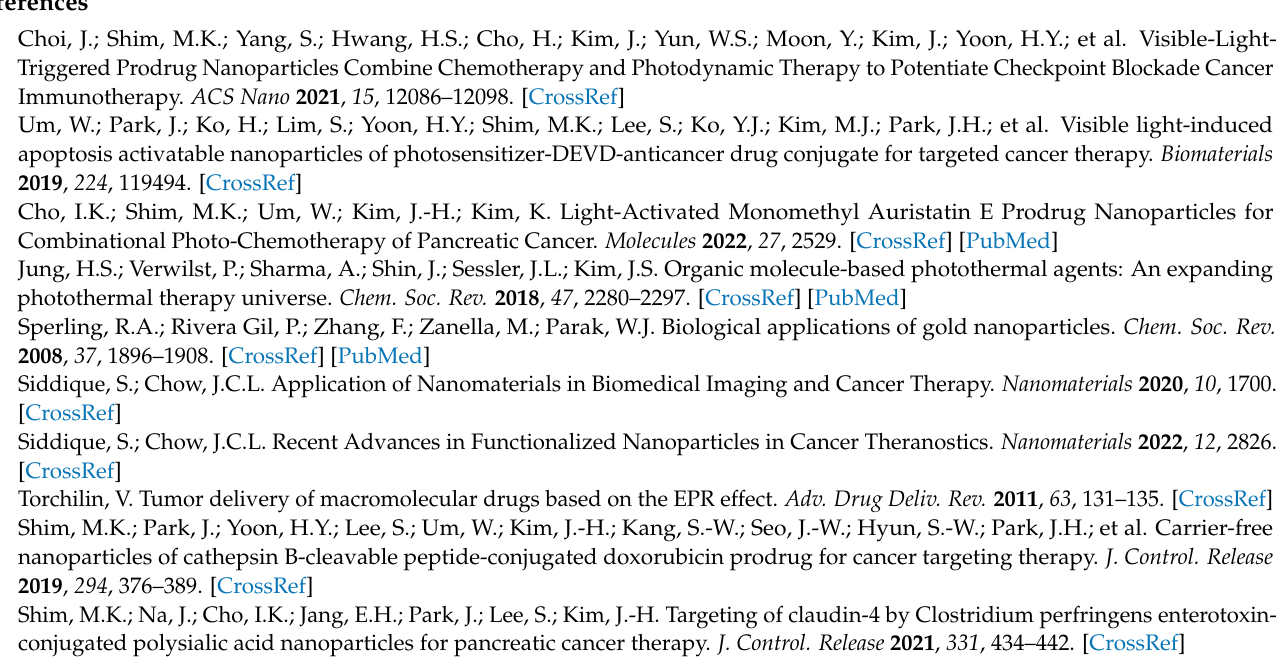
protocol for the preparation of AuNR@MSCs. Figure S2. Fluorescence image of MSCs treated with BCN-Cy5.5 (without Ac 4 ManNAz treatment) for 48 h. Figure S3. The photothermal efficiency